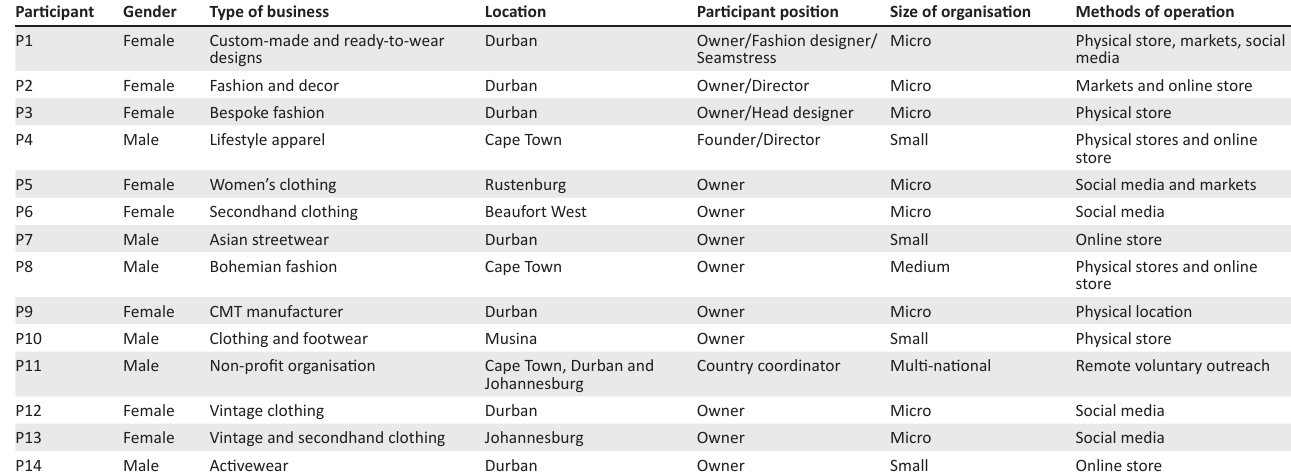
TABLE 1: Prof﻿ile of study participants and